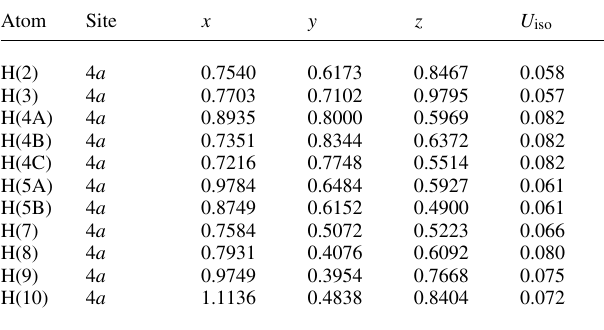
Table 2. Atomic coordinates and displacement parameters (in Å 2 )